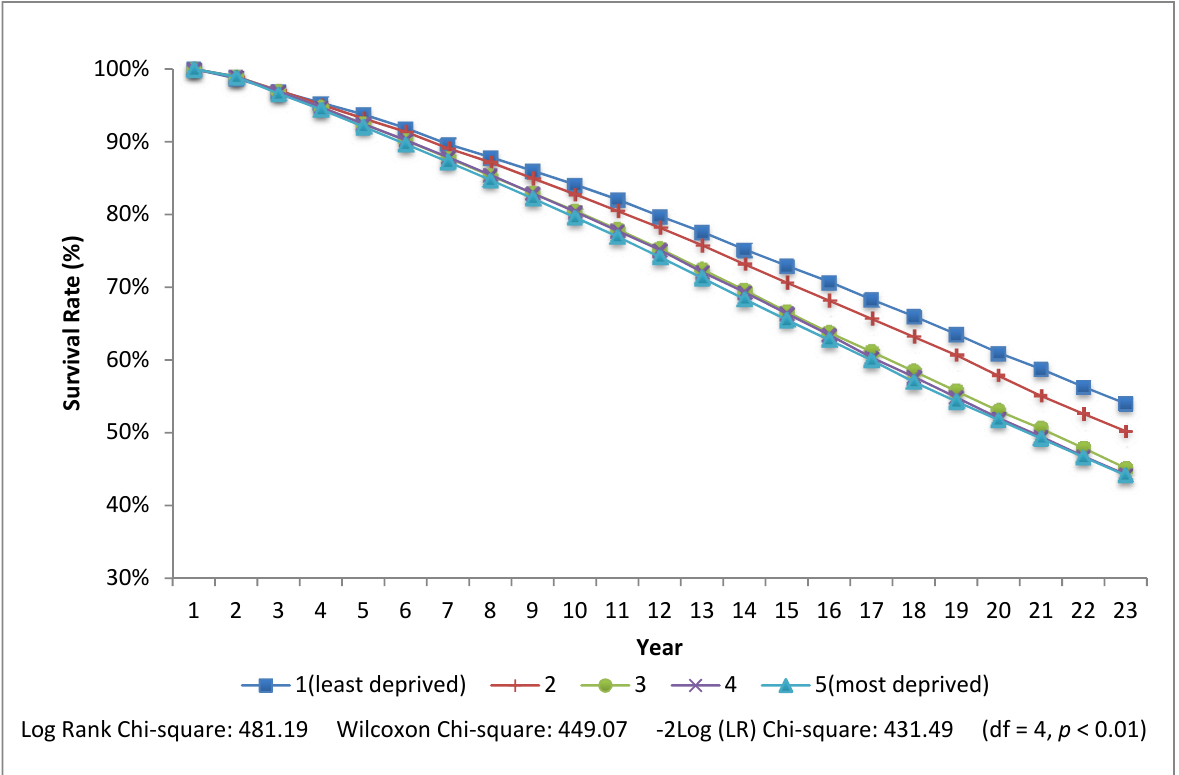
Figure 1. Rate of survival by quintiles of neighbourhood social deprivation for low income individuals.